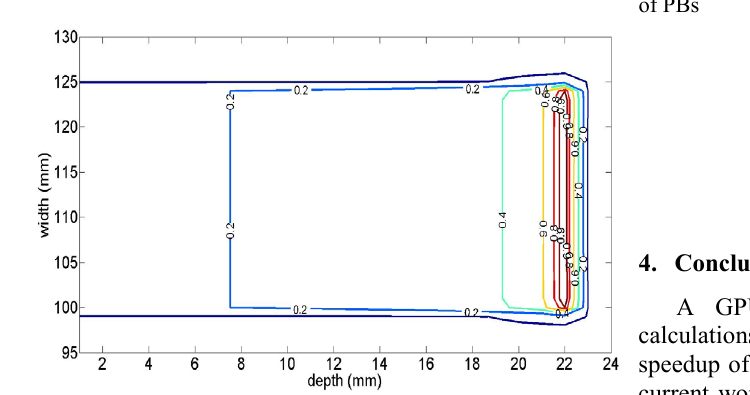
Fig. 7. 2D dose distribution of a proton PB with energy 150 MeV in water.